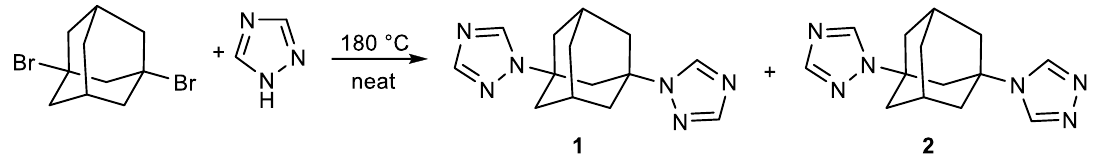
Figure 1. The scheme of reaction between 1,3-dibromoadamantane and 1,2,4-triazole.